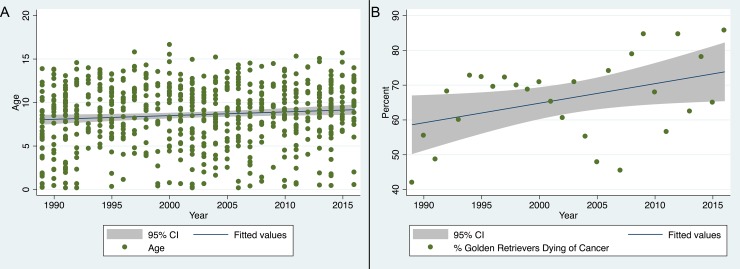
Percent of golden retriever dogs dying of cancer and age of death over time.(A) Scatter plot with fitted regression line and 95% CI showing percent of golden retriever dogs undergoing necropsy exam that died from cancer by year. The results show a significant (P = 0.38, R2 = 0.16) but weak increase in the proportion of dogs with a cancer diagnosis over time. (B) Scatter plot with fitted regression line and 95% CI showing age of golden retriever dogs presenting for necropsy over time. The results show a significant but week increase in age over time (P = 0.01, R2 = 0.009).